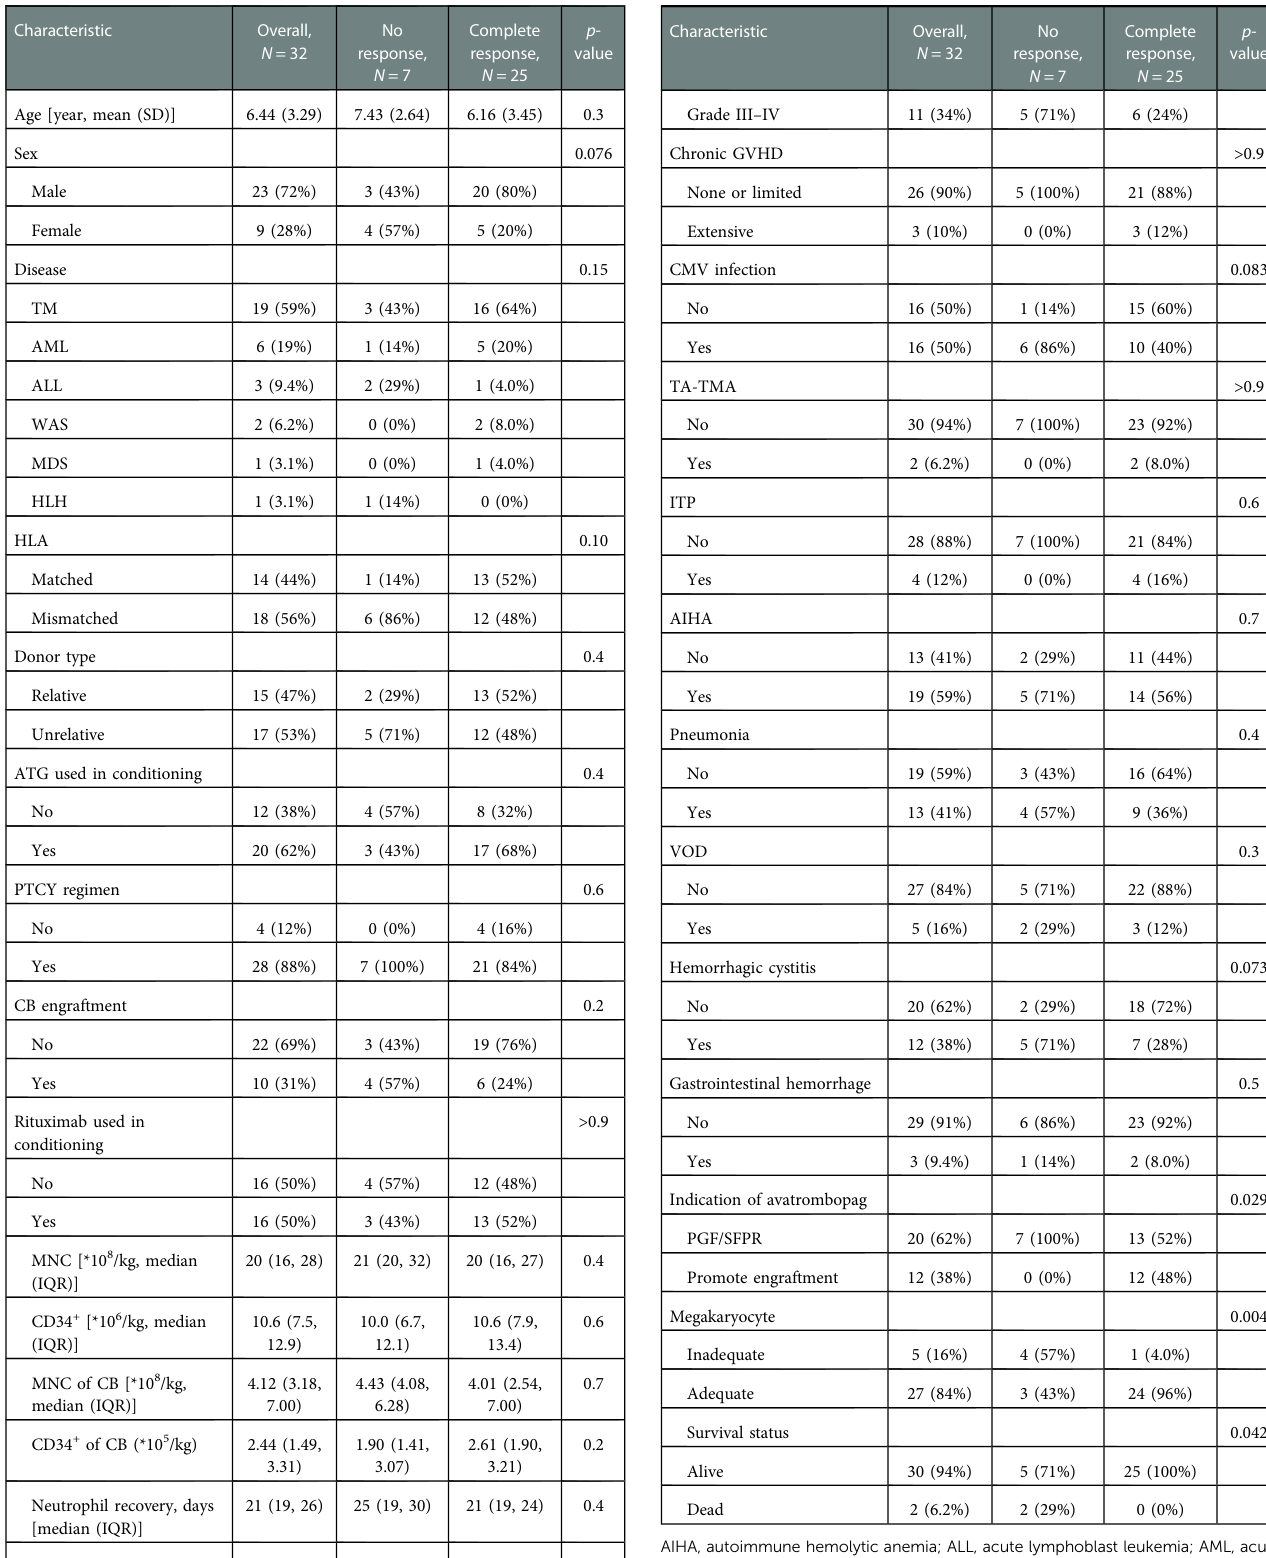
TABLE 1 Characteristics of